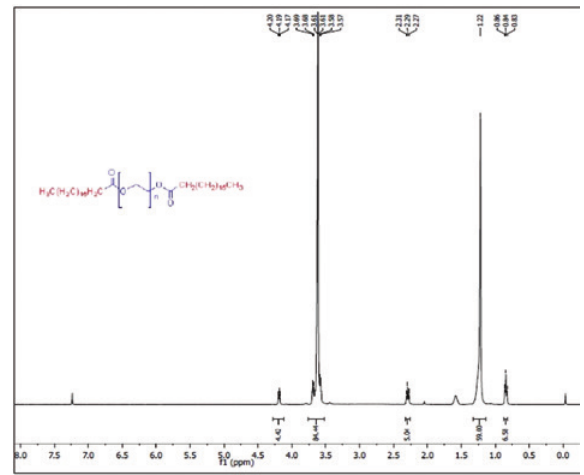
Figure 8: 1 H NMR of PEG